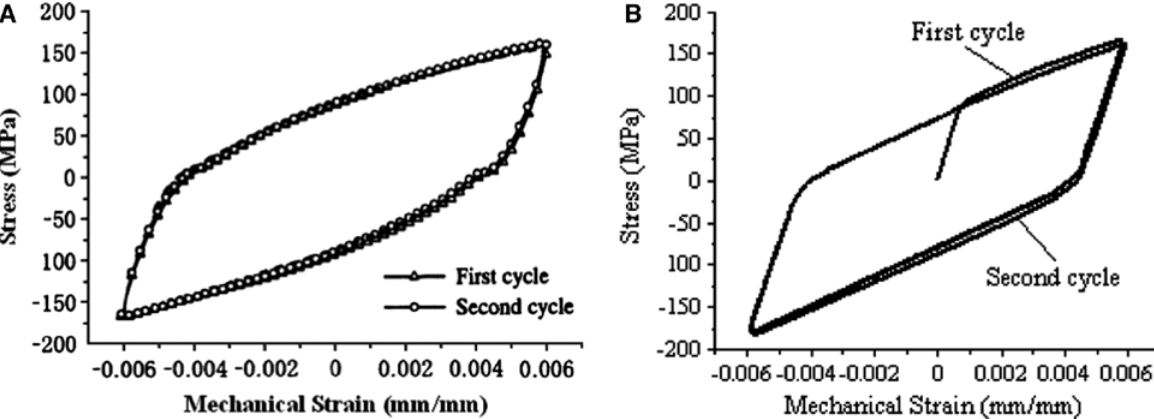
Figure 5: Comparison between calculated stress-strain responses and experimental results under isothermal loading: (A) experimental results and (B) calculated results of the proposed model.